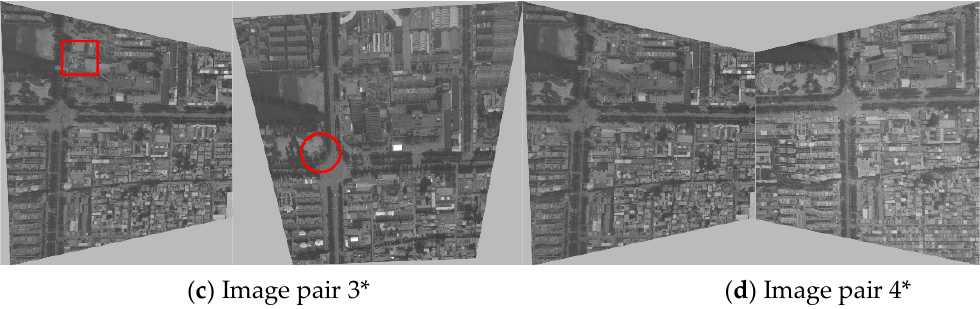
Figure 8. Rectified images with perspective projection transformation. ( a ) Image pair 1*; ( b ) Image pair 2*; ( c ) Image pair 3*; ( d ) Image pair 4*. The red rectangle indicates a rectanglar building and the red circle indicates a round object, respectively, on the rectified images.